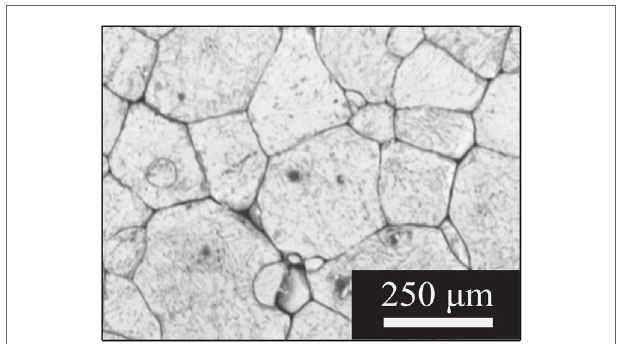
FigUre 1 | seM image of the surface of a large-grained llZO pellet used for this study .